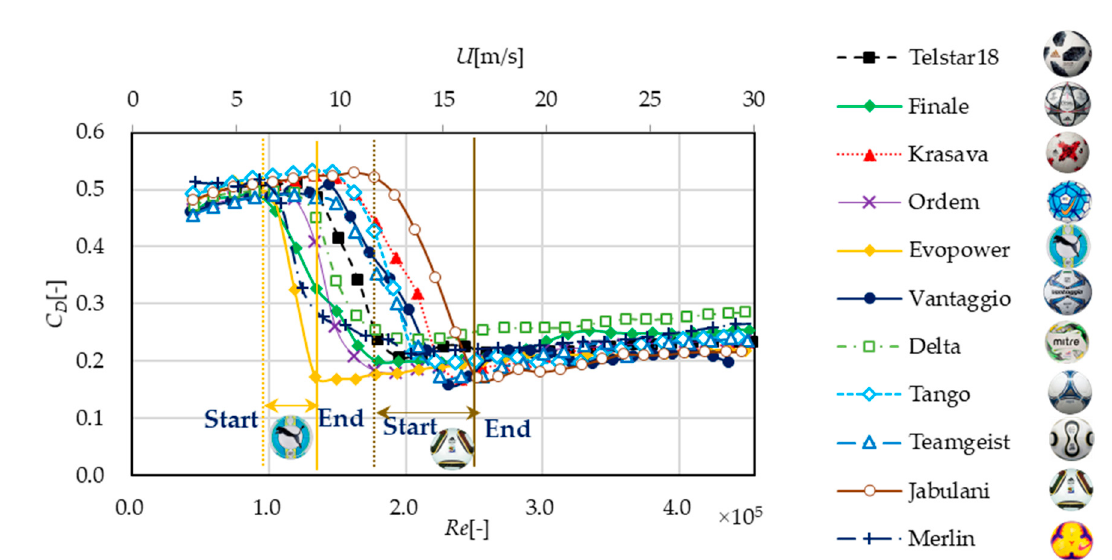
Figure 1. The coefficient of drag ( C D ) diagram of each